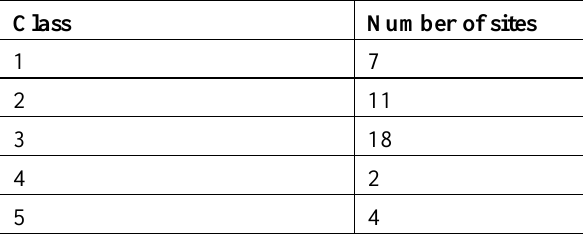
Table 15. Number of sites in each